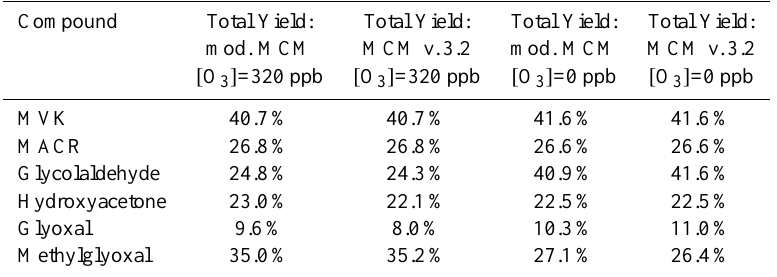
Table 3. Total molar yields from isoprene oxidation calculated with the modified MCM and original MCM v.3.2 for high NO x conditions. Total yields are calculated by allowing the model to run until species of interest have reacted away. Columns 2 and 3 are model simulations in which the conditions were held constant at the end of the experiment to determine total yields ( [ O 3 ] =320 ppb; OH = 8 . 2 × 10 5 molec cm − 1 ). Columns 4 and 5 are for identical runs, except that [ O 3 ] was set to 0 ppb. The observed glyoxal at the end of the experiments was only about 2/3 of the modelled output from columns 2 and 3. Compound Total Yield: Total Yield: Total